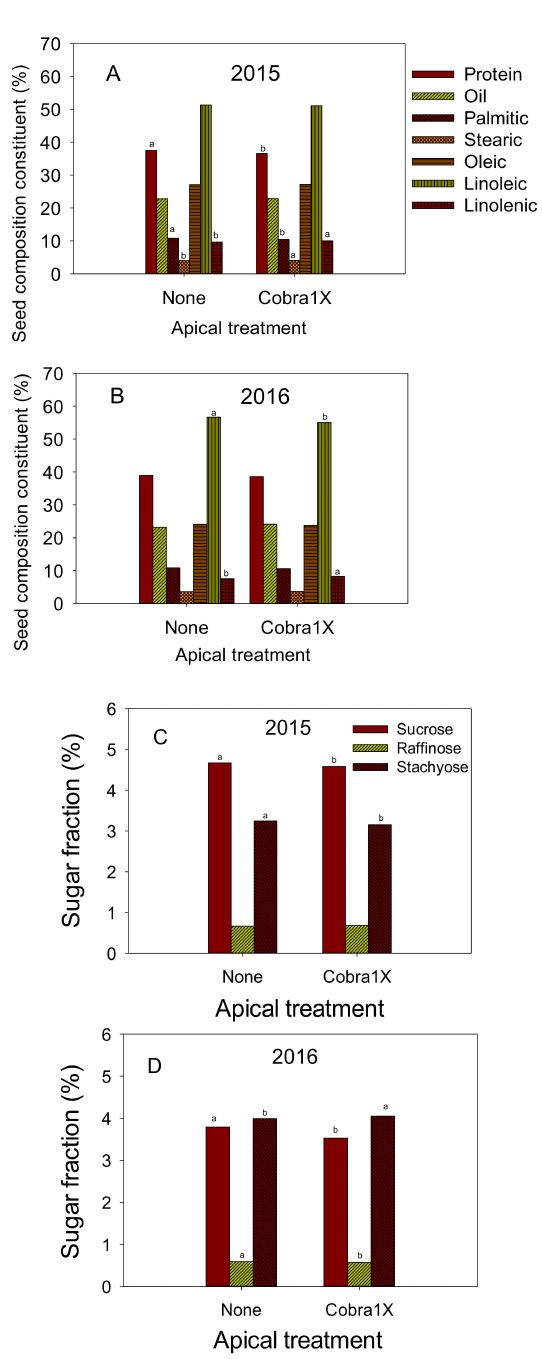
Figure 1. E ff ect of apical treatment of Cobra1X (rate of 12 oz / ac = 0.88 L ha − 1 ) on seed protein, oil, and fatty acids palmitic, stearic, oleic, linoleic, and linolenic (%) in 2015 ( A ) and 2016 ( B ); E ff ect of apical treatment of Cobra1X (rate of 12 oz / ac = 0.88 L ha − 1 ) on seed sugars (sucrose, ra ffi nose, and stachyose) (%) in 2015 ( C ) and 2016 ( D ). Bars with the same colors and patterns with di ff erent letters are significantly di ff erent at P = 0.05. Bars without letters are not